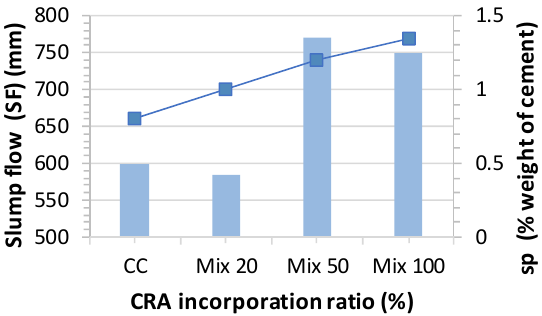
Figure 11. Slump flow and superplasticizer content.